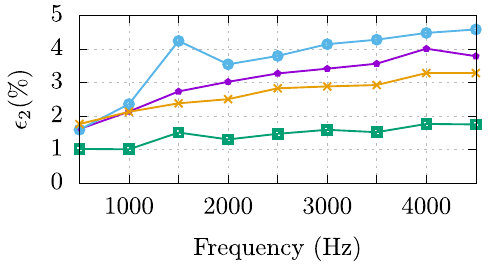
Figure 11. Convergence of the radiating cylinder